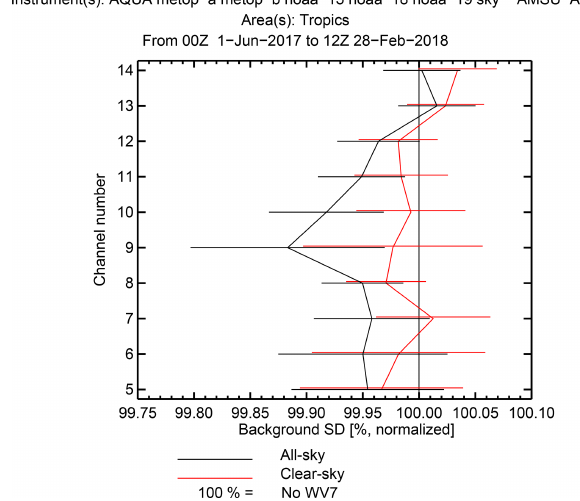
Figure 16. As in Fig. 14 but for AMSU-A in the